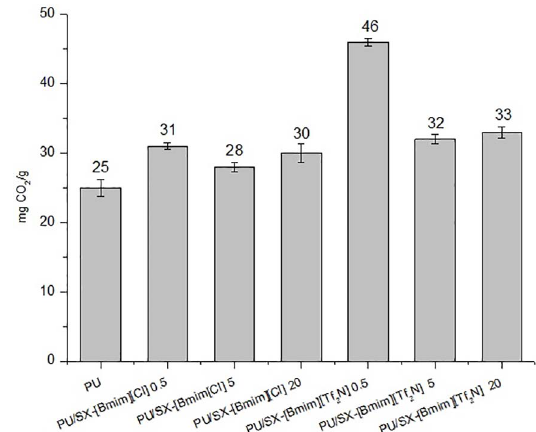
sorption capacity values at 2